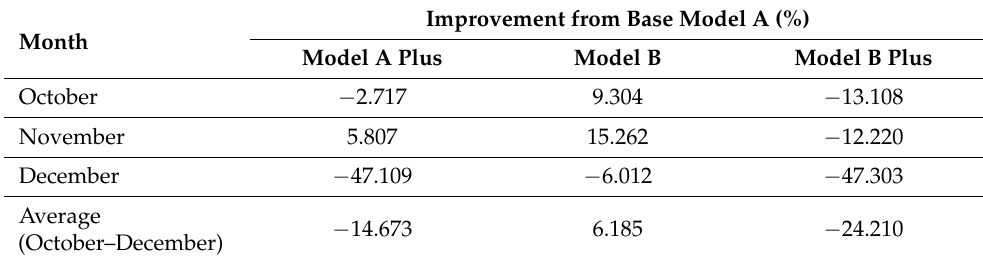
Table 5. Improvement offered by other models from the base model.